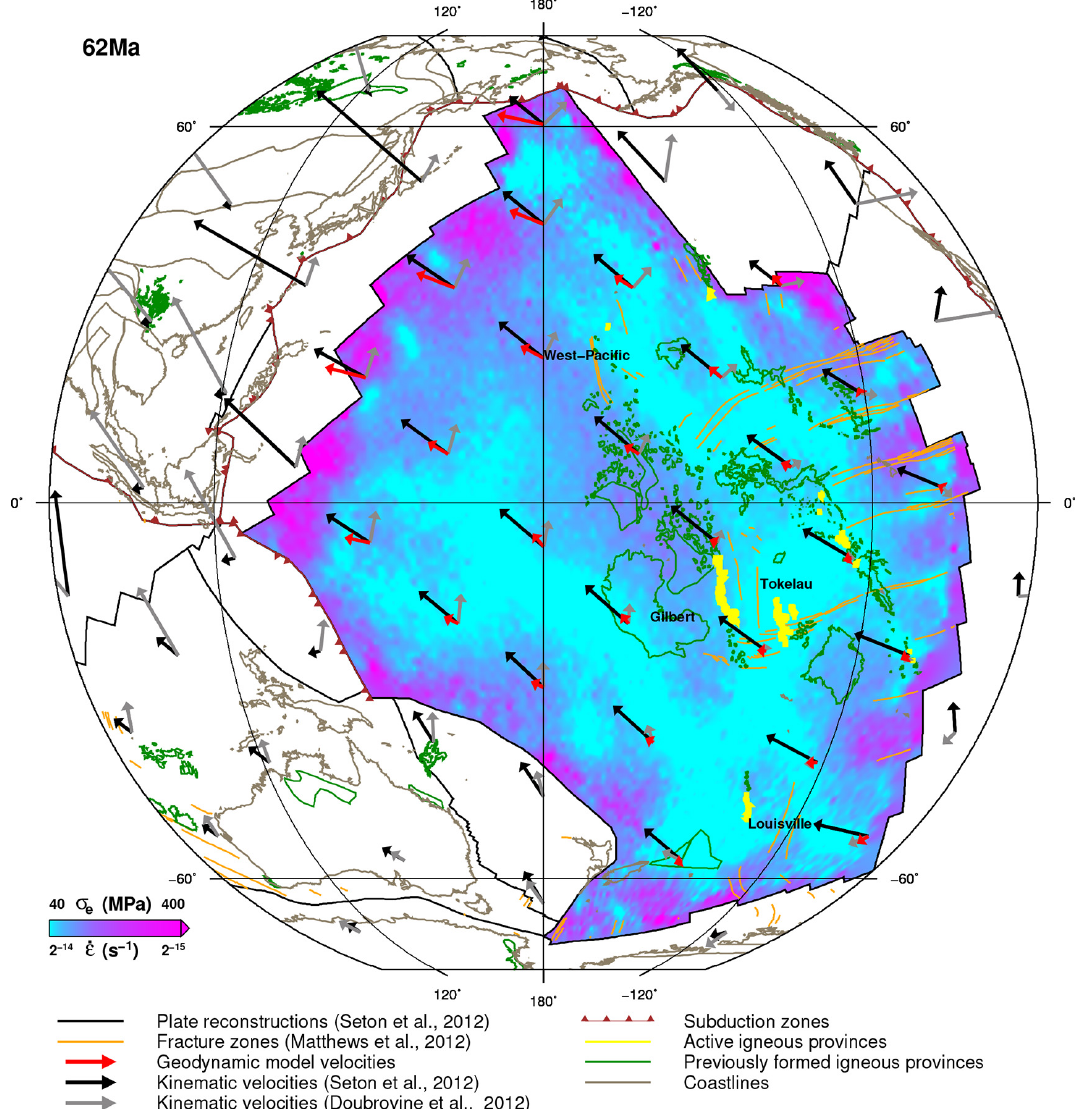
Figure 2. Pacific plate reconstruction and model output at 62Ma. Palaeo-plate reconstructed positions (Seton et al., 2012) are outlined in black, with attached subduction zones in red. Velocities of kinematic plate reconstruction models are shown by the black (Seton et al., 2012) and grey arrows (Doubrovine et al., 2012). Our subduction-model-derived velocity vectors are shown by red arrows. The yellow features are the reconstructed positions of age-dated igneous provinces that have appeared in the 10Myr preceding the model (see discussion for references). Igneous structures are outlined in green. Significant locations are labelled. Orange lines are the reconstructed fracture zone locations (Matthews et al., 2011). The brown outlines represent the reconstructed positions of the present-day coastlines. The aqua to magenta logarithmic colour scale represents the second deviatoric stress invariant ( σ e ) of our model and the strain rate ( ˙ ε = σ e / 2 η s ), with aqua representing minimal potential for plate deformation and magenta representing the maximal potential for deformation at the surface of the modelled plate. The smooth, homogeneous style of deformation at the borders of divergent and passive margins is a post-processing artefact due to the interpolation of the grid of the deviatoric stress values onto the reconstructed edge of the plate